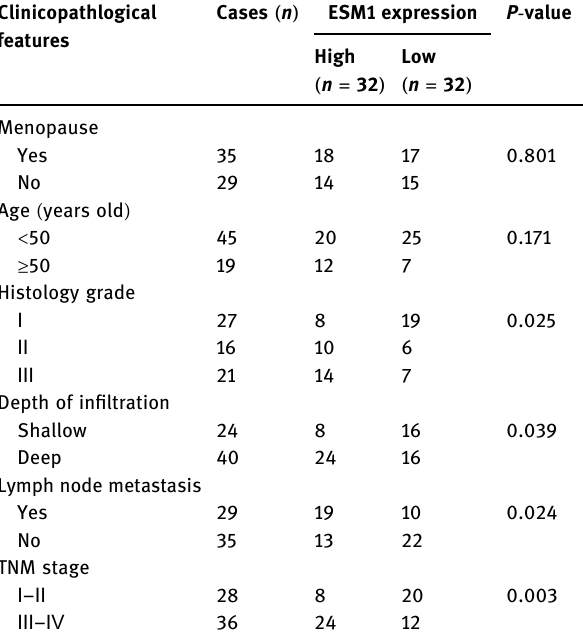
Table 1: Relationship between the expression of ESM1 and the clinical characteristics of endometrial cancer